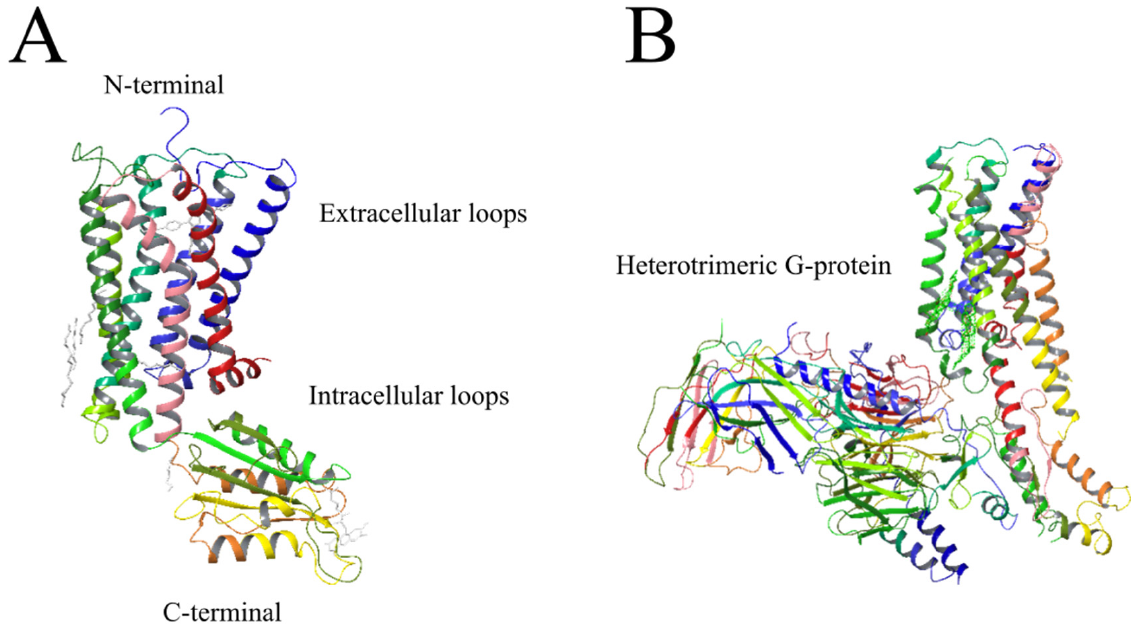
Figure 1. ( A ) Helical structure of CB1-R [85]. ( B ) Helical structure of the G( i )-signaling complex made up of the CB1-R and the G( i ) subunit alpha-1, subunit beta-1, and subunit gamma-2 heterotrimeric proteins [26]. Seven hydrophobic transmembrane segments are connected by loops that extend into the extracellular and intracellular domains alternatively [26]. Modified using Schrödinger Release Software 2021-4: Maestro, Schrödinger, LLC, New York, NY, 2021. The CB1-R integral membrane protein with seven membrane-spanning helices cou- pled to heterotrimeric G-proteins on the intracellular side is depicted in Figure 2. The cell membrane is comprised of glycerophospholipids, molecules composed of glycerol, a phosphate group, and two fatty acid